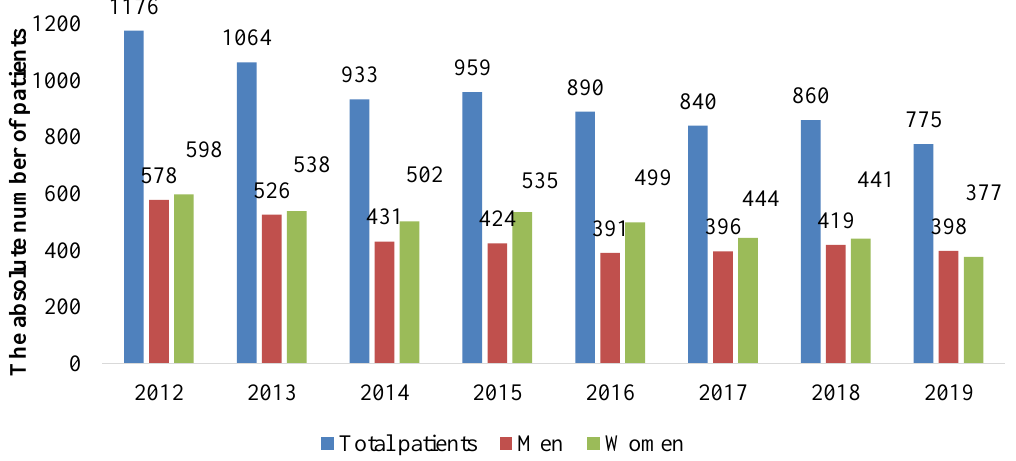
Fig. 1. The results of the analysis of the dynamics of changes in the incidence rates of the population of Ukraine during 2012–2018 for LGM and their forecast for